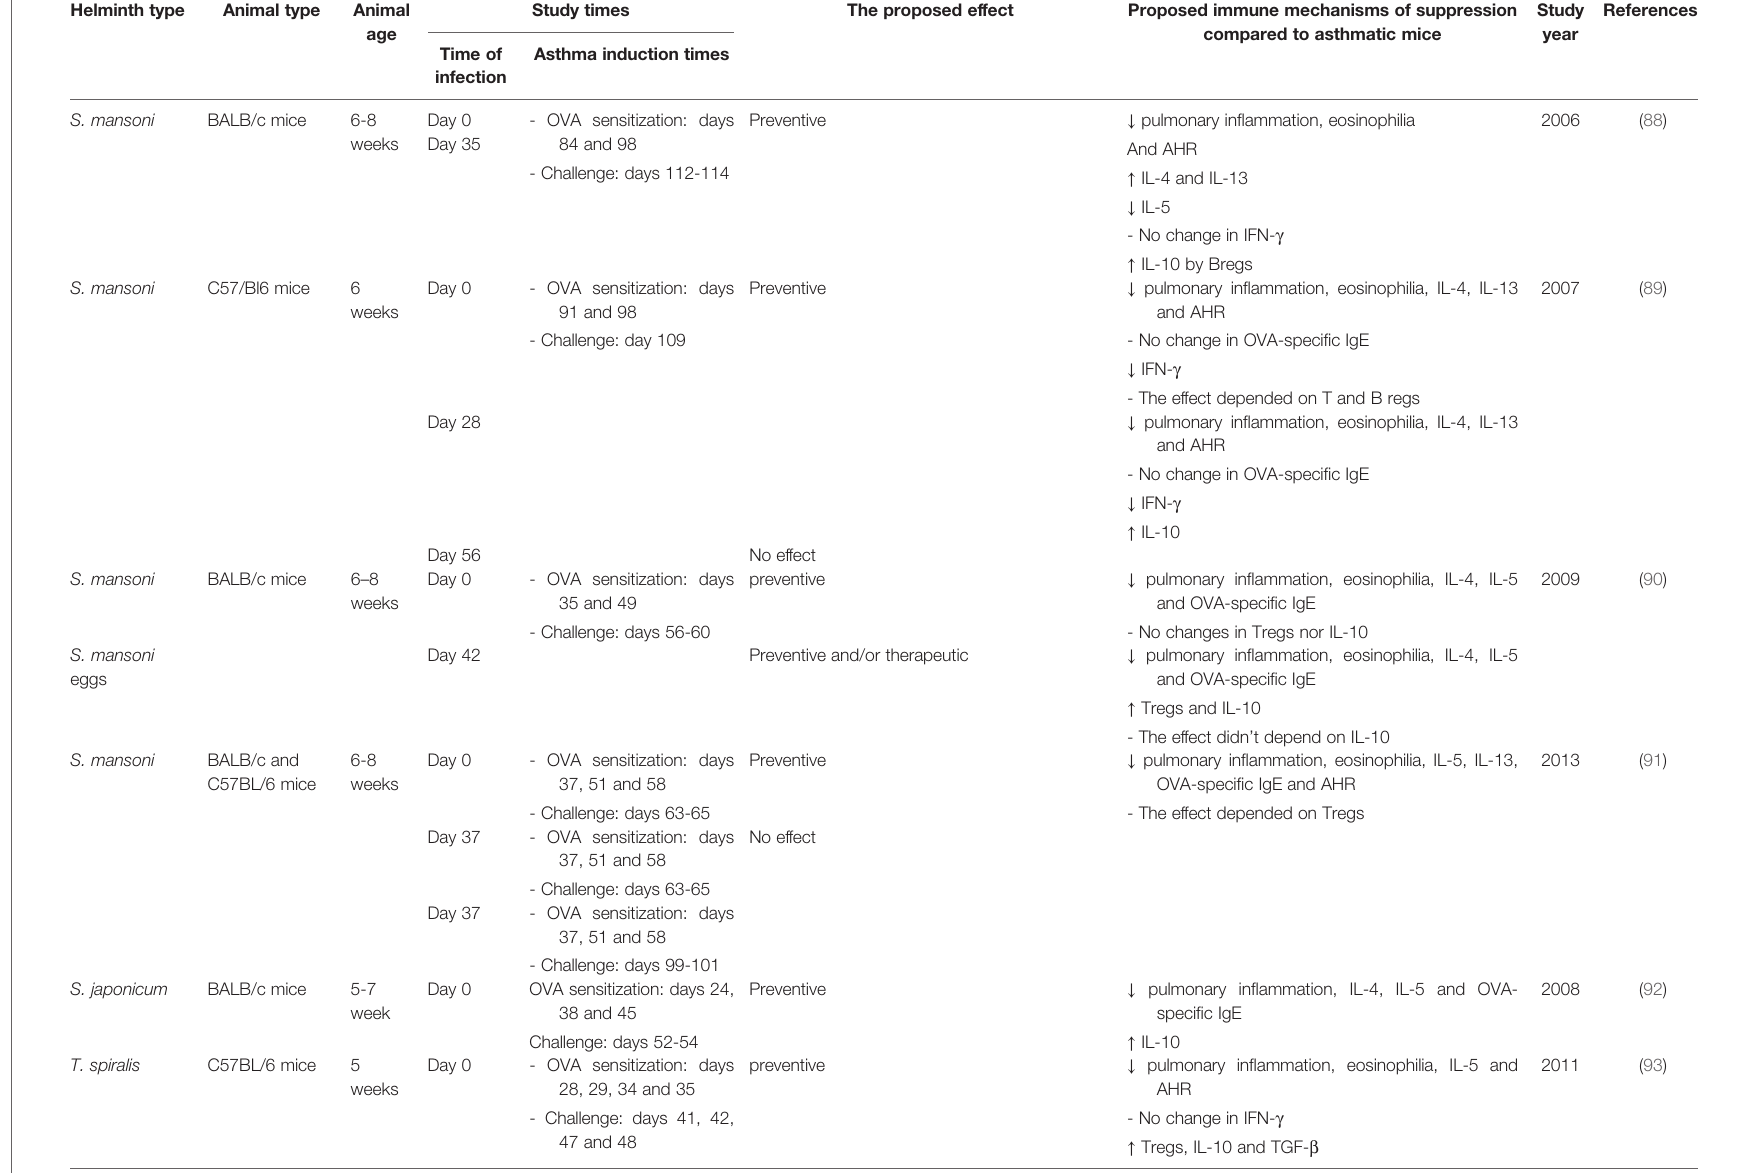
TABLE 3 | Impact of helminths infection on experimental murine allergic